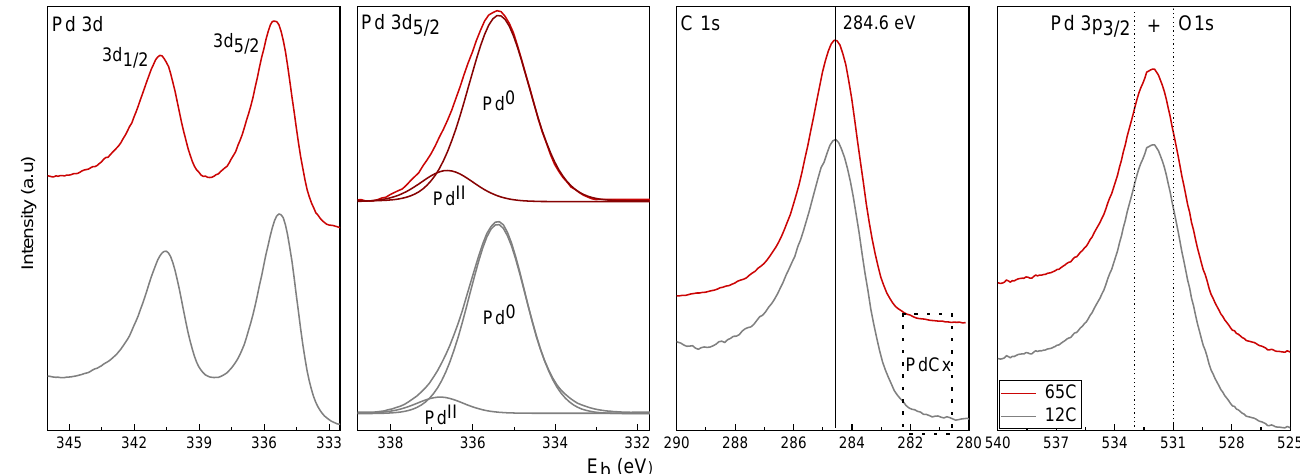
Figure 5. XPS spectra of the 12C and 65C samples as deposited in SiC foam.